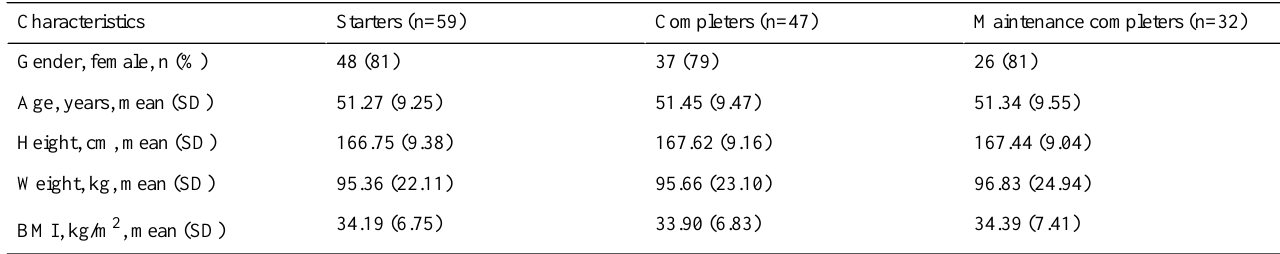
Table 1. Baseline characteristics of study starters, completers, and maintenance completers. BMI: body mass